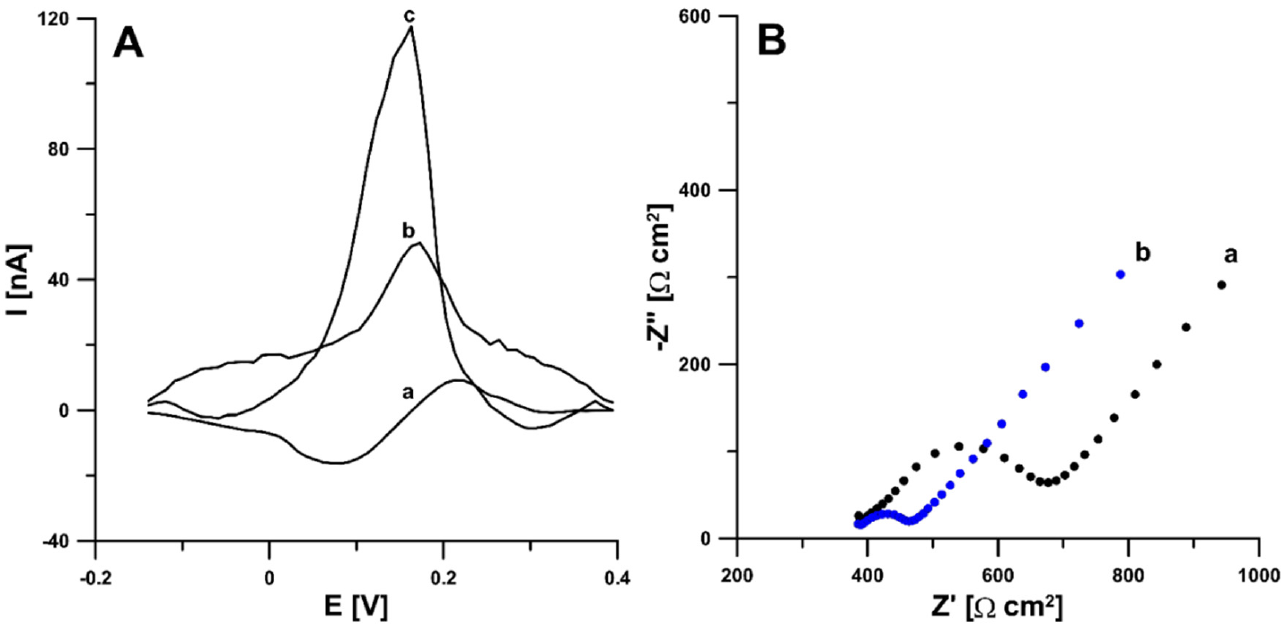
Figure 1. ( A ) Voltammograms of 0.2 nM rifampicin (RIF) in 0.1 M phosphate buffer saline (PBS) of pH 7.5 obtained at the bare screen-printed boron-doped diamond electrode (SPBDDE) (a), electrochemically activated in 0.1 M acetate buffer of pH 4.0 containing 10 mM H 2 O 2 SPBDDE (b) and electrochemically activated in 0.1 M NaOH SPBDDE (c). The differential pulse adsorptive stripping voltammetric (DPAdSV) parameters: Eacc of − 0.25 V, tacc of 60 s, ∆ E A of 50 mV, ν of 100 mV s − 1 and t m of 10 ms. ( B ) Nyquist plots of SPBDDE (a) and aSPBDDE (b).